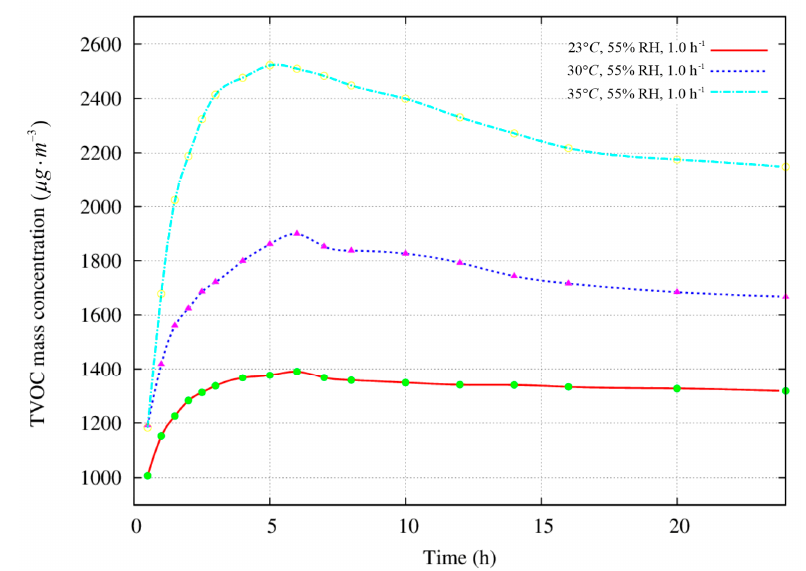
Figure 2. The total volatile organic compounds (TVOC) mass concentration of polyurethane (PU) athletics track changes with time from 23 to 35 °C.